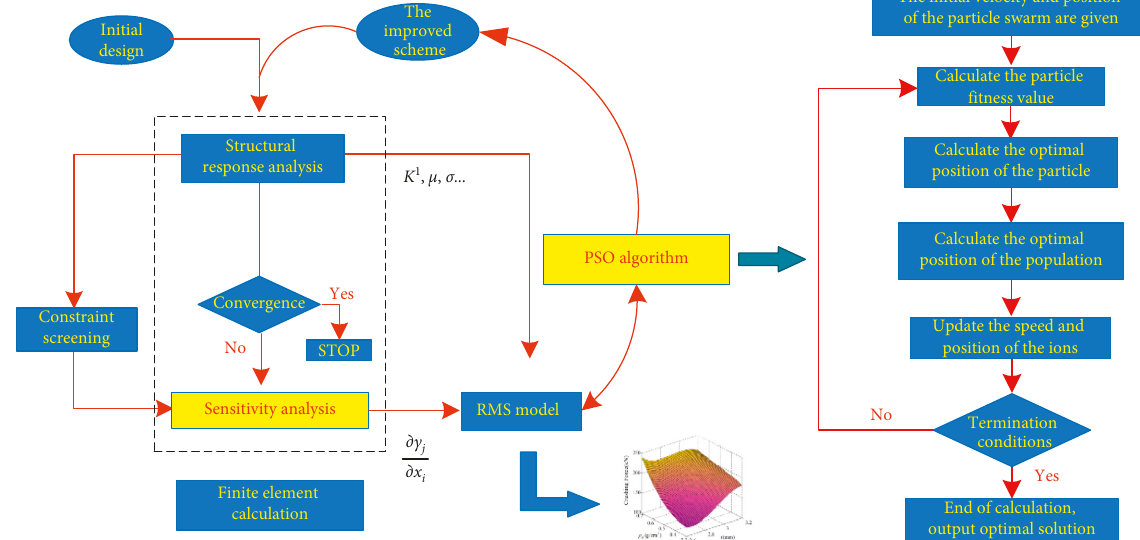
Figure 10: Operational logic diagram of the combined optimization